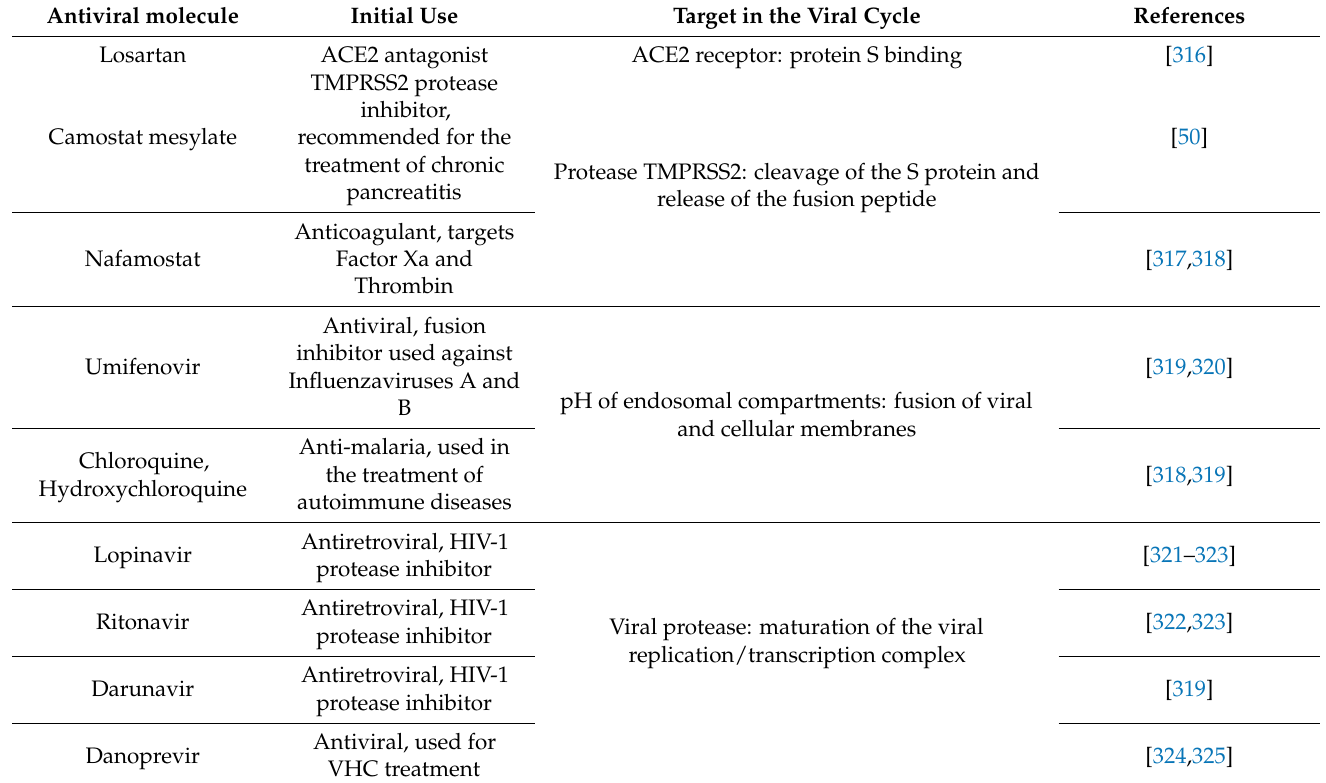
Table 1. Chemical drugs targeting the different steps of the virus life